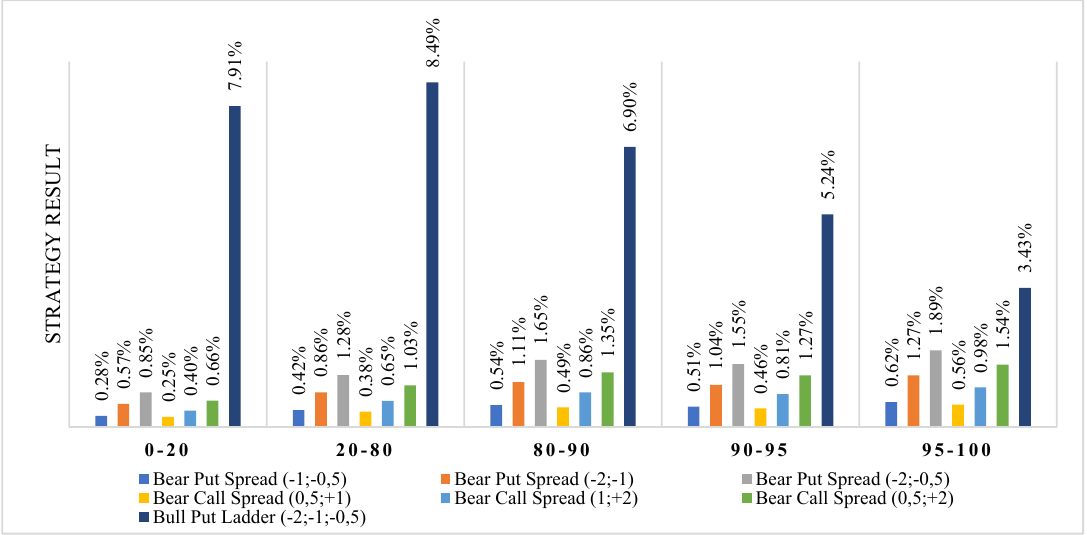
Figure 7. Bear put spread, bear call spread, and bull put ladder results for declines of WTI Crude Oil prices ranging from 10% to 20%. Energies 2020 , 13 , x FOR PEER REVIEW